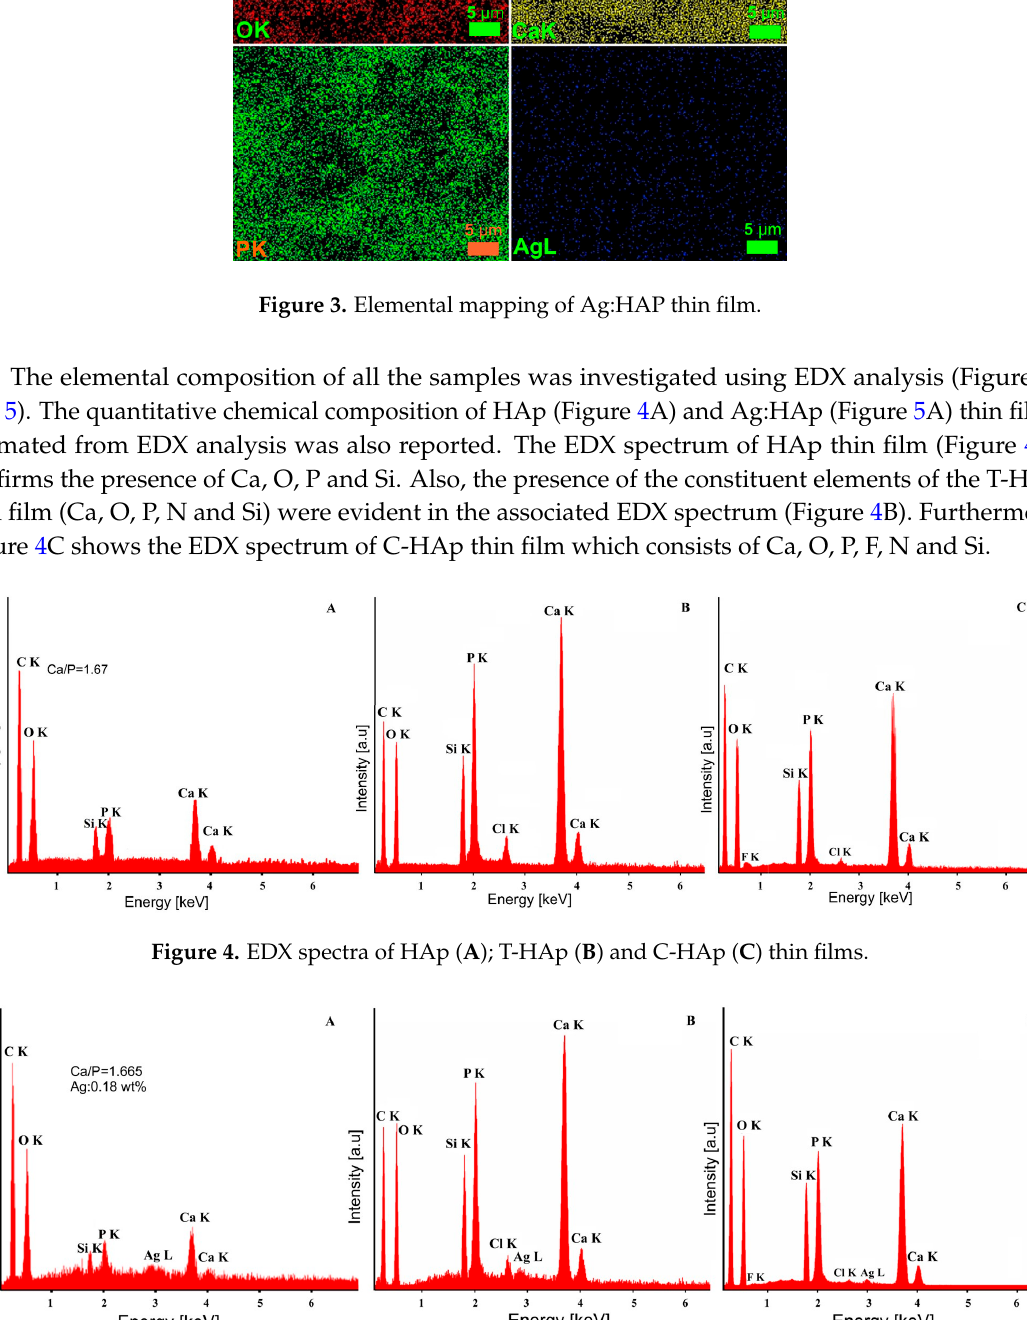
Figure 3. Elemental mapping of Ag:HAP thin film.